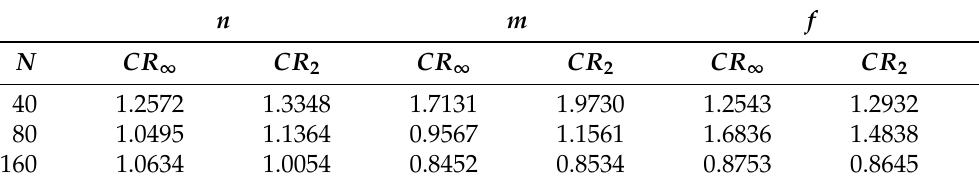
Table 3. Convergence rate of the original problem in different norms, Example 1.